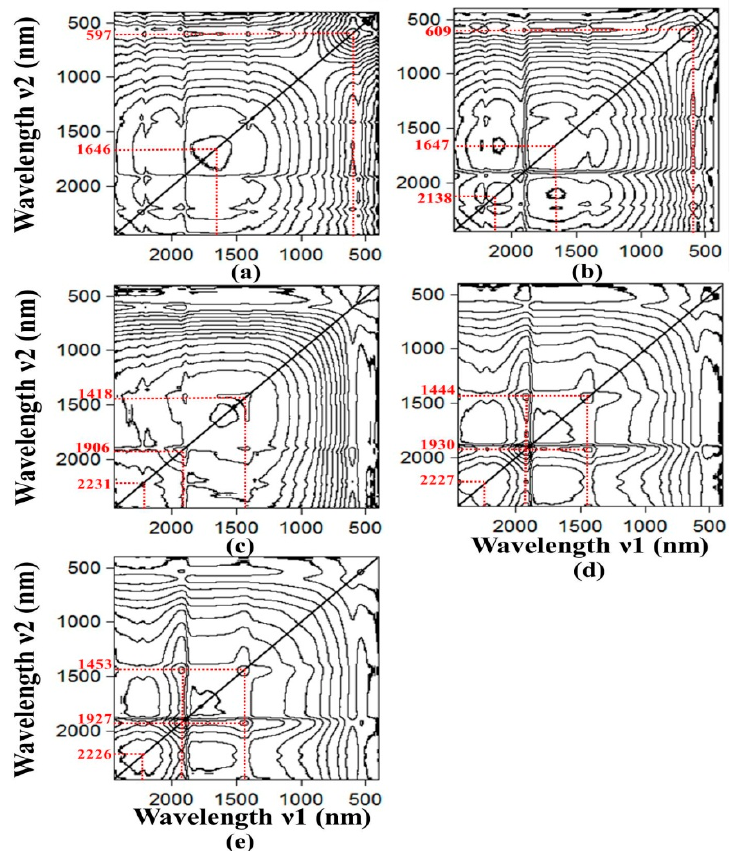
Figure 7. The contour plots of the 2D-COS of the soil samples with various SOM content (i.e., SOM as perturbation variable) for the moisture content of: ( a ) oven-dry, ( b ) 5%, ( c ) 10%, ( d ) 15% and ( e ) 17%. Note that the 2D-COS is formed by using spectra of samples that have various SOM content in each category of the moist soil sample.